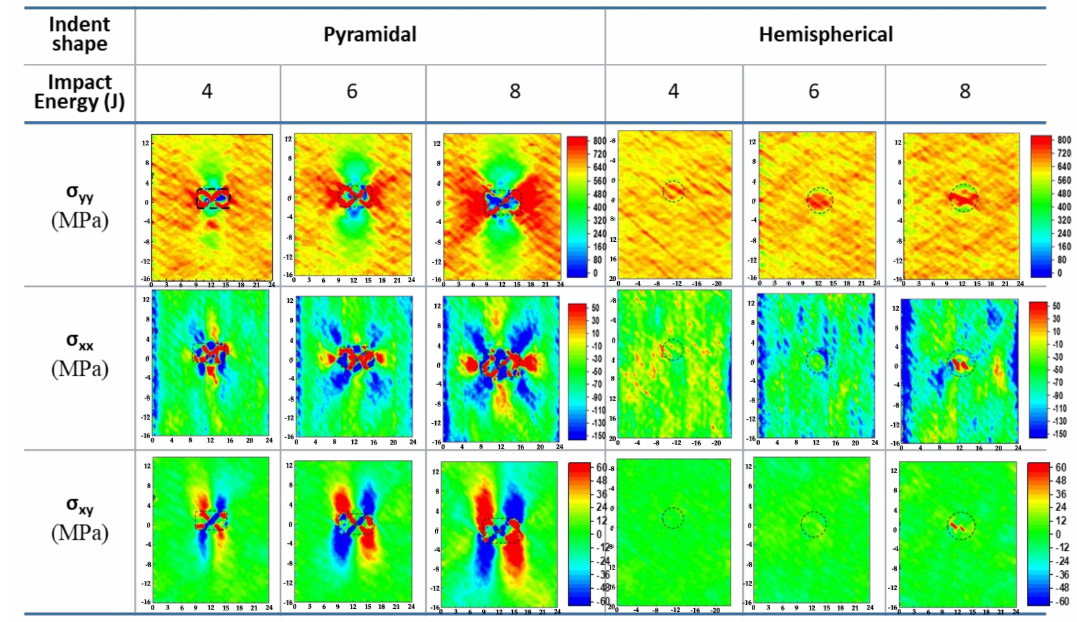
Figure 9. Typical directional stress, longitudinal ( σ yy ), transverse ( σ xx ) and shear ( σ xy ) stresses, distribution in the vicinity of the indents for TRI GFRP laminates (at tensile stress of 600